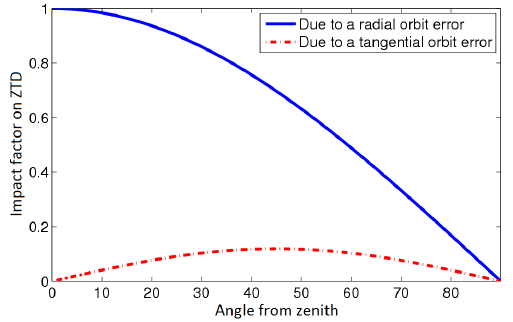
Figure 1. The impact of the radial and the tangential orbit errors in the estimated ZTD. Table 2. Accuracy of IGS reprocessed orbits for one day ∗